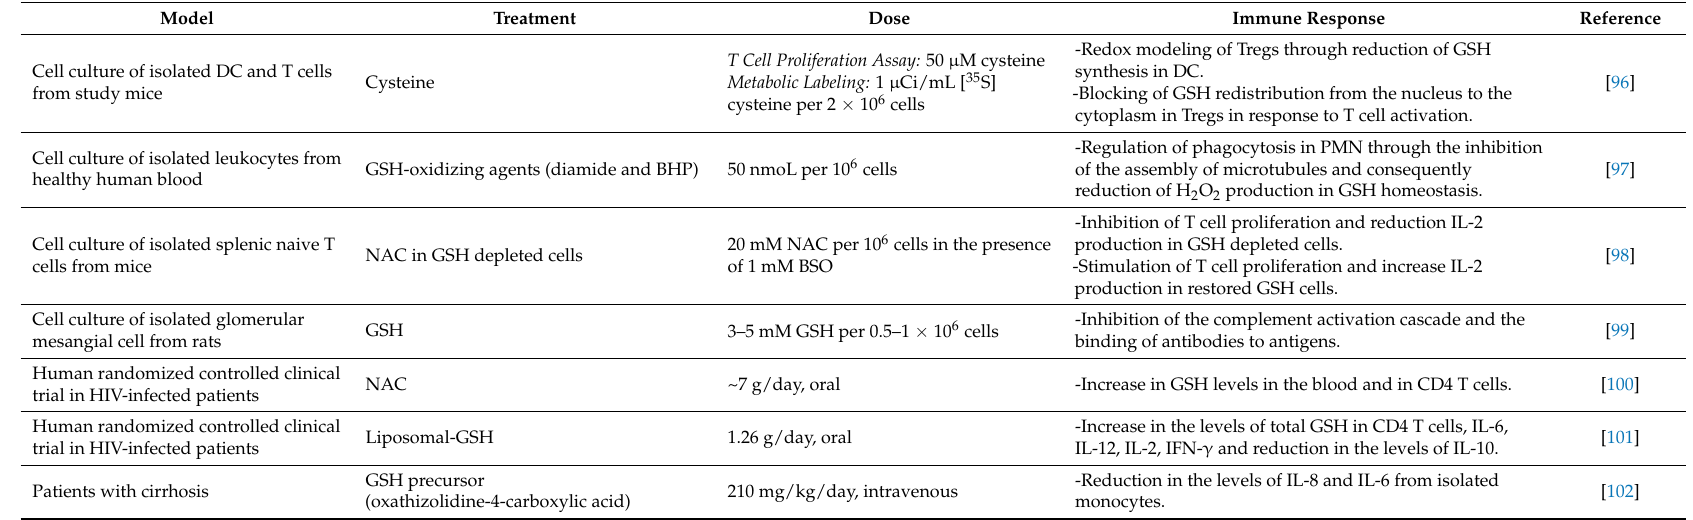
Table 1. Summary of previous studies on the effect of glutathione in the immune